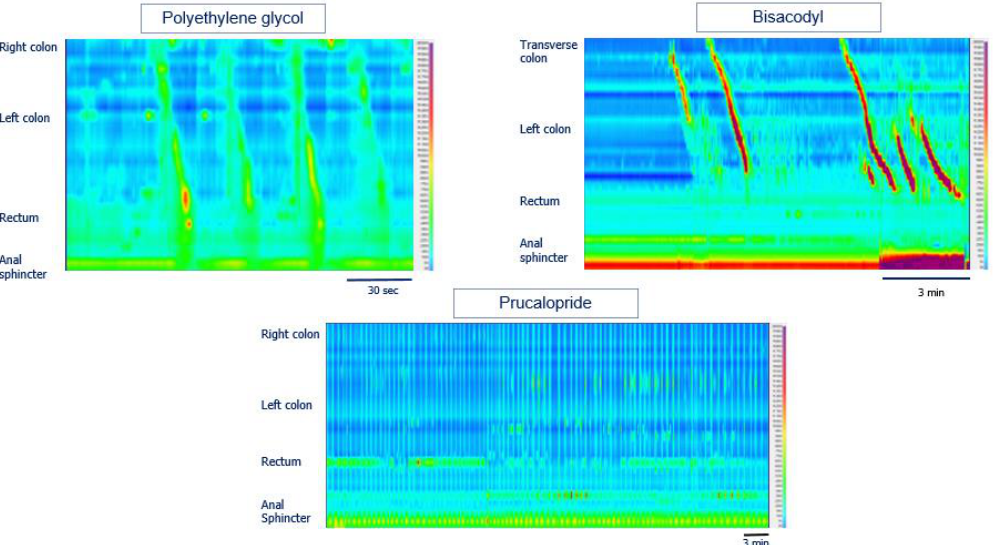
Figure 11. Motility patterns in the colon, the rectum, and the anal sphincter after exposition to polyethylene glycol, bisacodyl, and prucalopride, respectively. Reproduced with permission from Neurogastroenterology and Motility , Corsetti et al., “High-resolution manometry reveals different effect of polyethylene glycol, bisacodyl, and prucalopride on colonic motility in healthy subjects: An acute, open label, randomized, crossover, reader-blinded study with potential clinical implications ” [53],